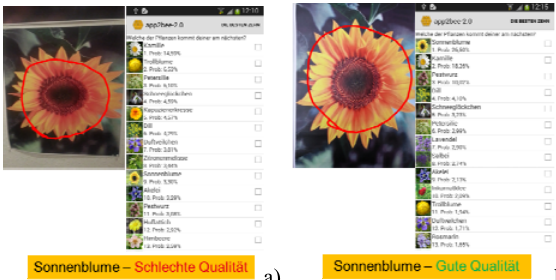
Figure 24: Influence of the image quality on the classification results, a) Sun-flower with poor image quality, b) Sun-Flower with good image quality (Source: Shohrab